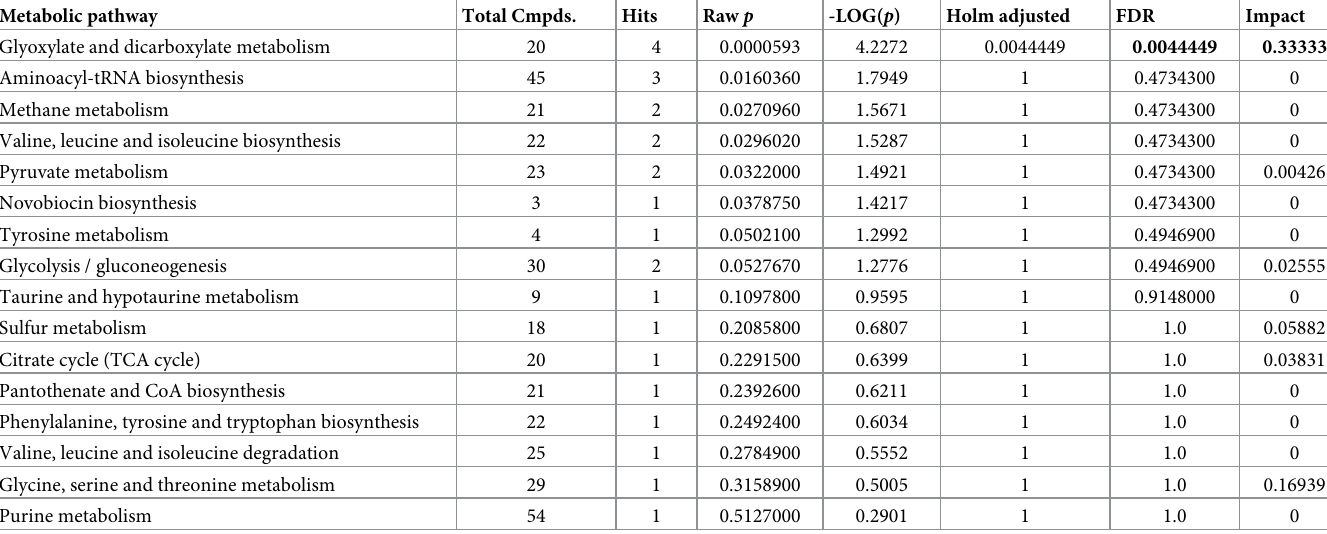
Table 2. Metabolic pathway analysis of the SPMAP09 strain after crystallization in AU observed at initial point (day 0) and day 3. Metabolic pathway Total